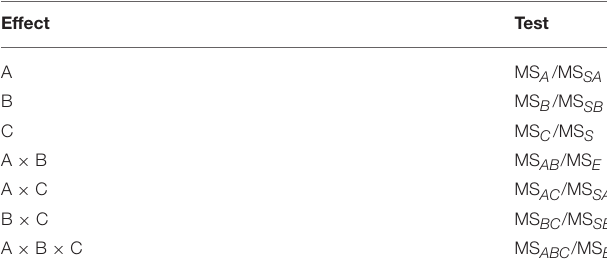
TABLE 6 | The EMS ratios used to form appropriate F -tests for the main effects and interactions in a 3-way mixed-measures ANOVA. Effect